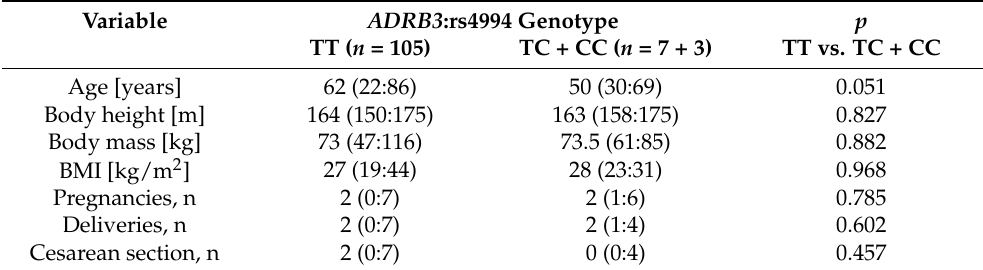
Table 1. Basic characteristics and pre-procedure urodynamic parameters of women with overactive bladder in regard to ADRB3 :rs4994